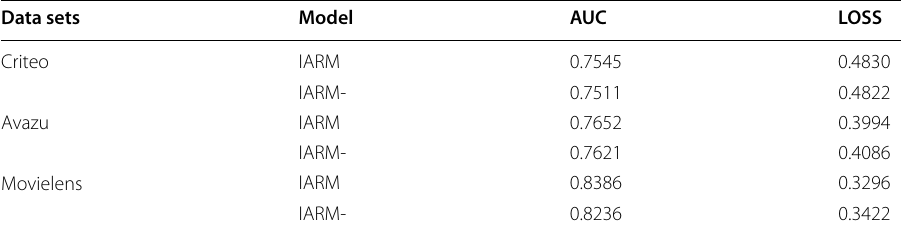
IARM is a full model, whereas IARM- is a residual network-free model